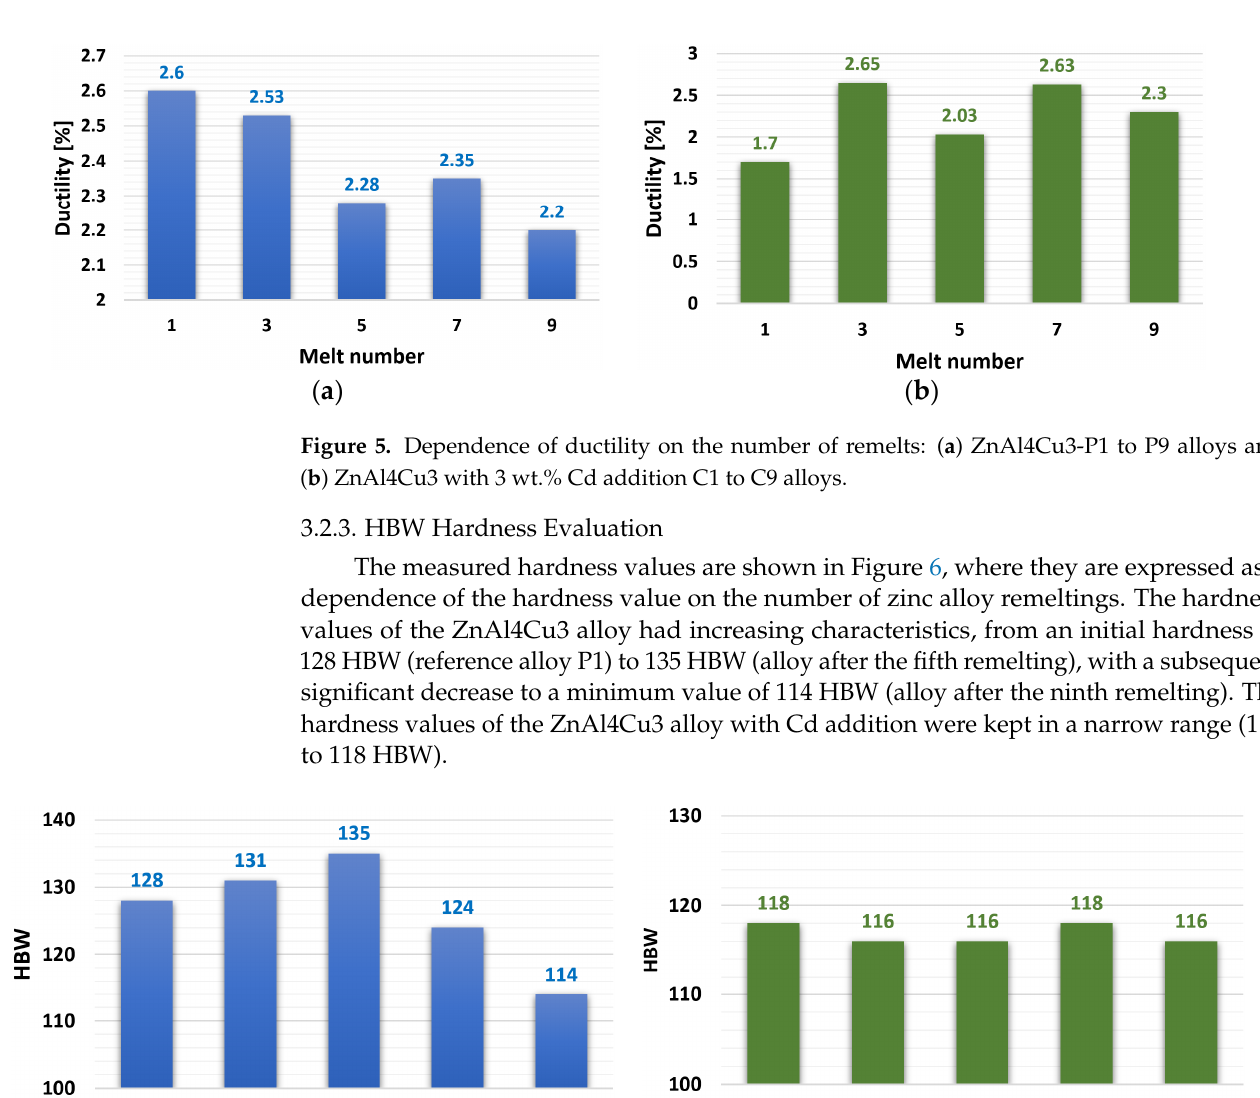
( b ) Figure 7. Microstructure of the ZnAl4Cu3 sample after first remelting (P1 alloy): ( a ) etched 0.5% HF and ( b ) etched Dix–Keller. From the microstructural images of the ZnAl4Cu3 alloy after the fifth (Figure 8) and after the ninth (Figure 9) remelting, an increase in the number of bright spots can be ob- served in images with etched 0.5% HF, which represent dendrites of η phases. This in- crease was observed with each subsequent remodeling.